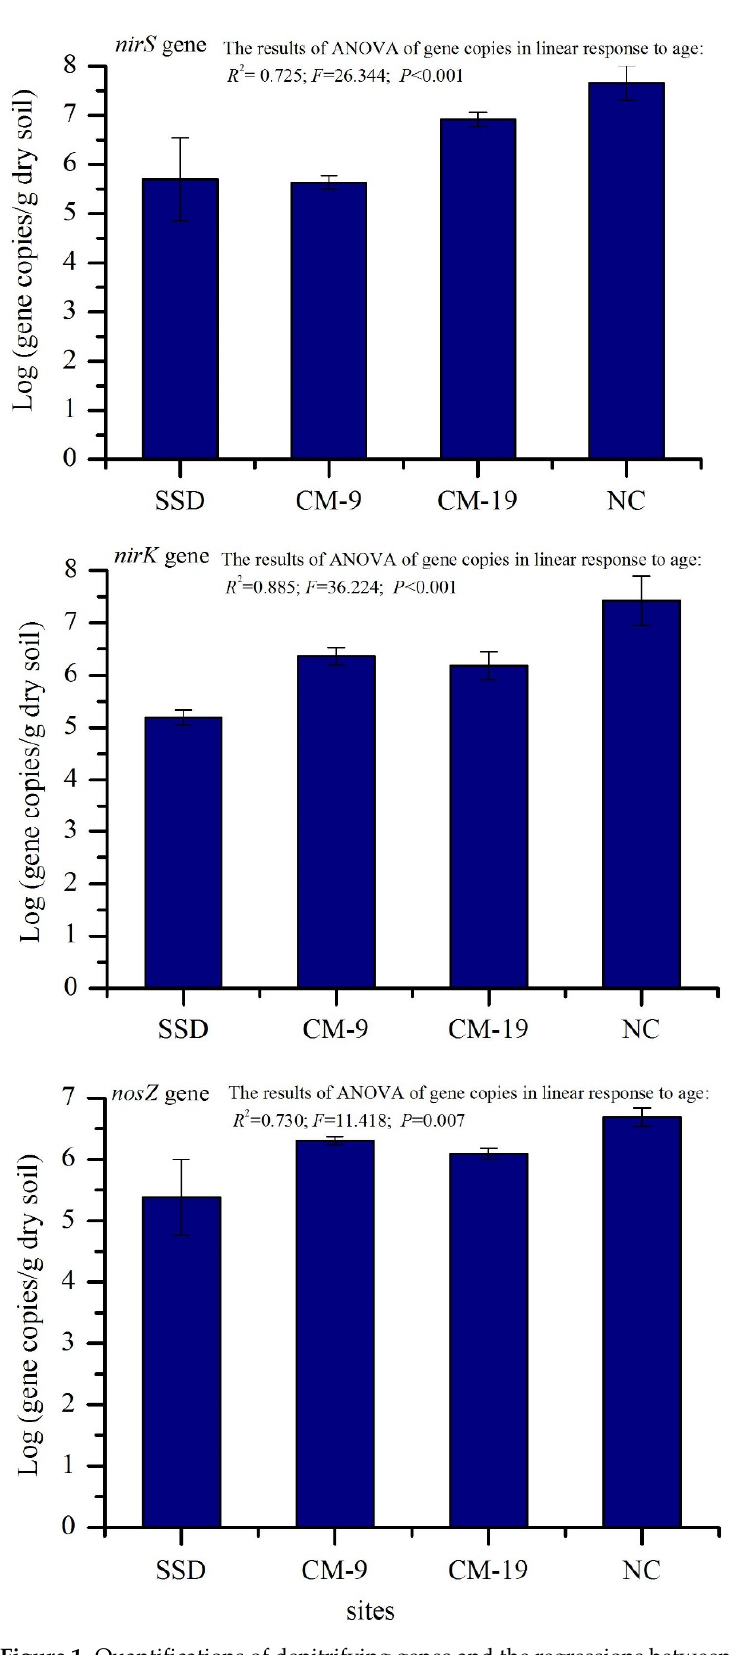
Figure 1. Quantifications of denitrifying genes and the regressions between the logarithm of the gene copies and forest age. SSD: shifting sand dune; CM-9: 9-year C. microphylla forest; CM-19: 19-year C. microphylla forest; NC: natural C. microphylla forest.